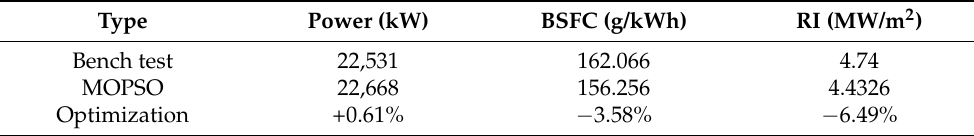
Table 9. Comparison between bench test results and MOPSO optimization